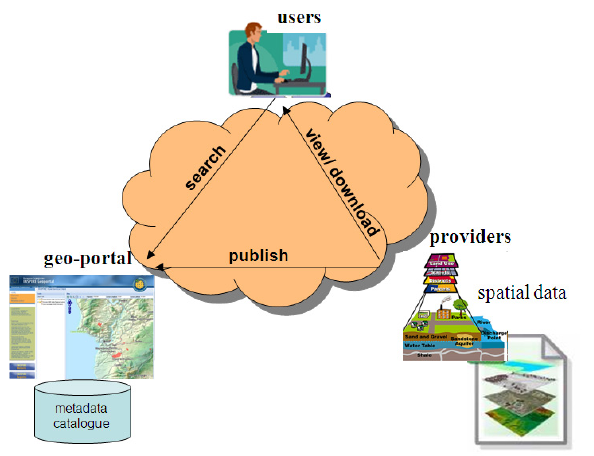
Fig. 1. Publishing, searching and using information in a geo-portal